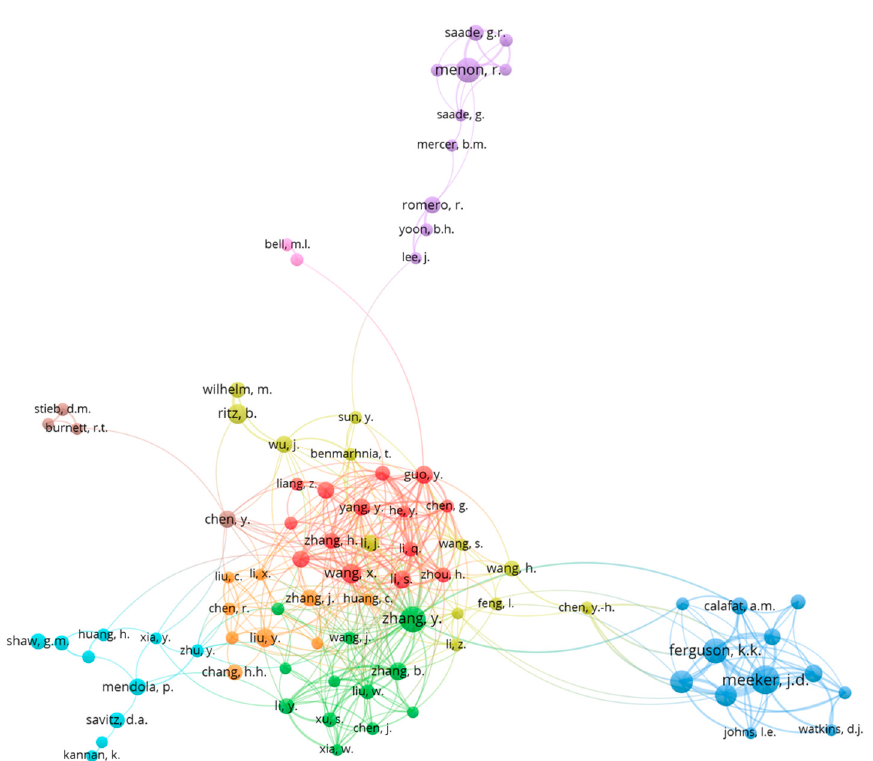
Figure 3. Co-authorship network showing multiple clusters of co-authors, with centralization among a majority of Chinese authors.